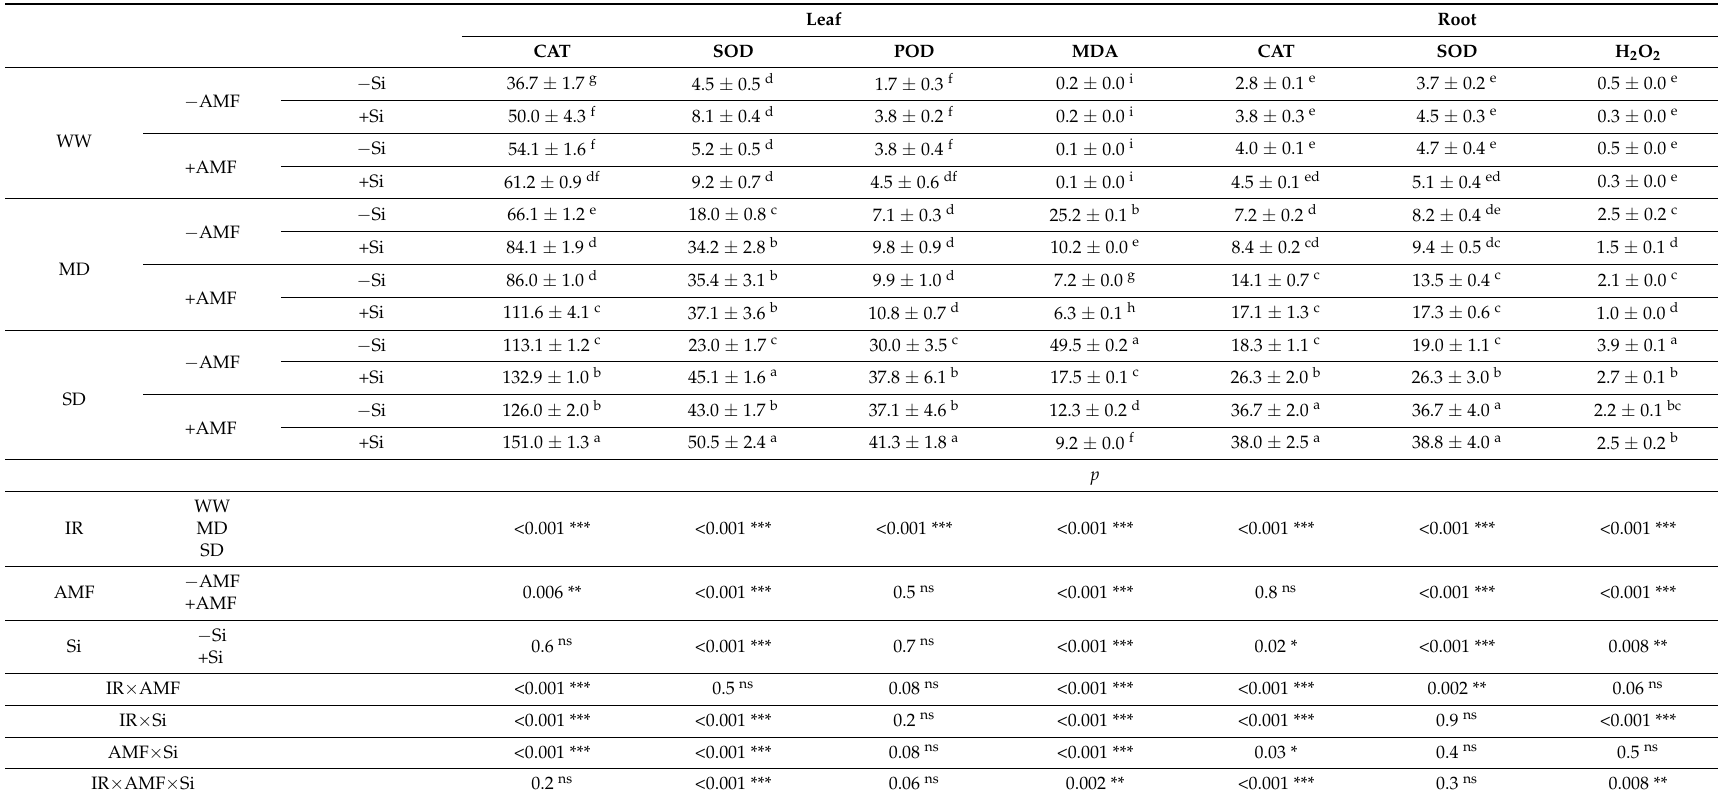
Table 3. The activity of catalase (CAT, µ mol mg − 1 protein min − 1 ), superoxide dismutase (SOD, Unit mg − 1 protein min − 1 ), and peroxidase (POD, ( µ mol tetra guaicol mg − 1 protein min − 1 ) and the concentration of malondialdehyde (MDA, nmol g − 1 FW) in the leaf and the activity of CAT and SOD and the concentration of hydrogen peroxide (H 2 O 2 , µ mol g − 1 FW) in the roots of strawberry plants at harvest after six experimental weeks under three irrigation regimes (IR): well-watered (WW), mild drought (MD), and severe drought (SD) without ( − AMF) or with inoculation with arbuscular mycorrhizal fungus (+AMF) Rhizophagus clarus (Walker & Schüßler), in the absence ( − Si) or presence of silicon (+Si, 3 mmol L − 1 Na 2 SiO 3 ). The numbers show the treatment means (4 replicates) ± SE of the mean. Means with the same letters are not significantly different. Interactions among the main factors are indicated as *** p < 0.001, ** p < 0.01, and * p < 0.05 and ns as not significant (Tukey test, alpha =